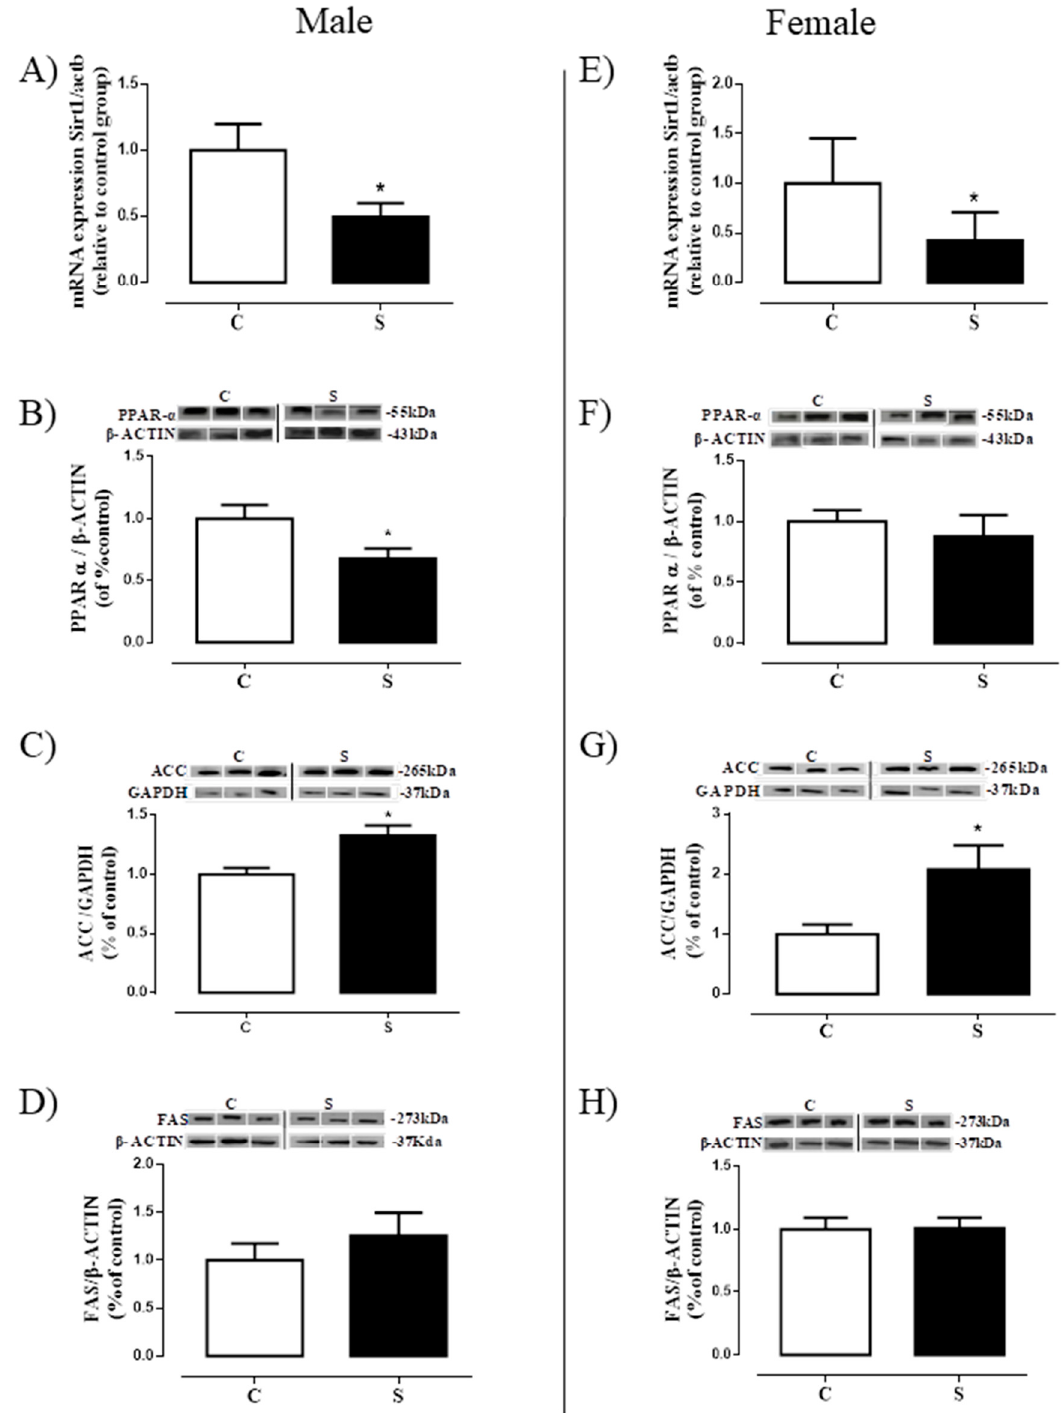
Figure 7. Lipogenesis in the liver of adult rats programmed by smoke exposure during the lactation period. Sirtuin-1 mRNA expression (Sirt1; A —male; E —female); peroxisome proliferator-activated receptor alpha (PPAR- α ; B —male; F —female); acetyl-CoA carboxylase (ACC; C —male; G —female); fatty acid synthase (FAS; D —male; H —female). Groups: C—CONTROL and S—SMOKE. Values are given as means ± S.E.M. of 5–7 rats/group. * p < 0.05 significant difference between S vs. C.